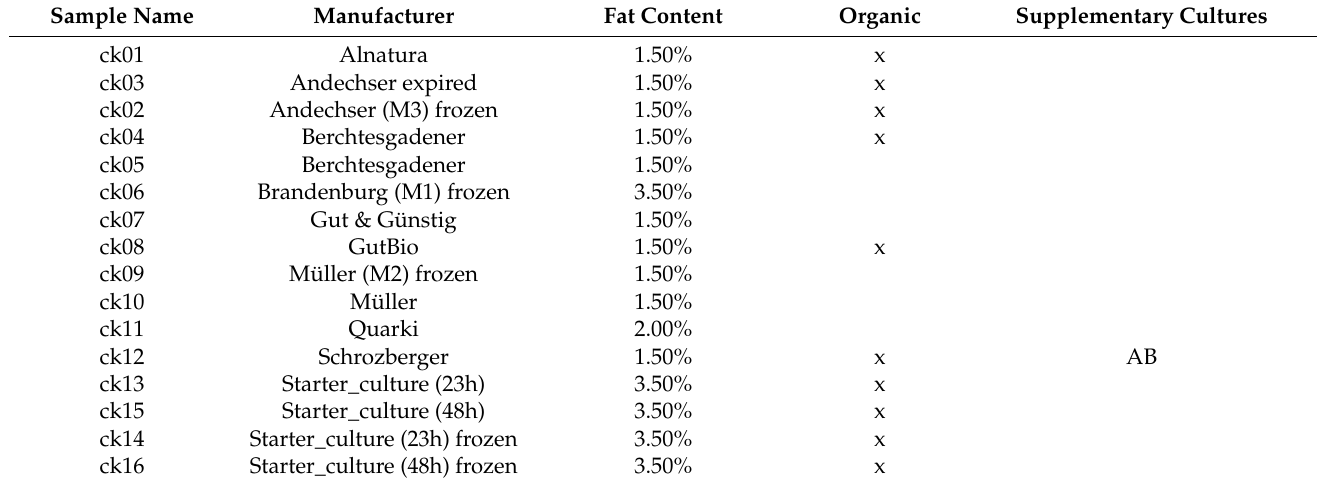
Table A1. Commercial kefir (ck) samples were purchased in local food stores in Germany. The manufacturer, fat content, and organic certification, as well as the supplementation with L. acidophilus (A) and B. bifidus (B), are listed.